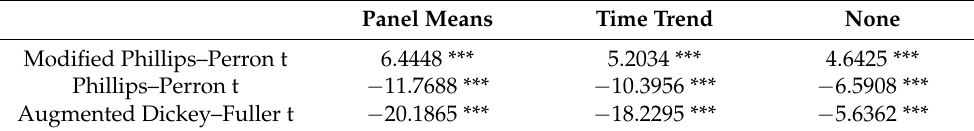
Table 3. Panel Cointegration Test.